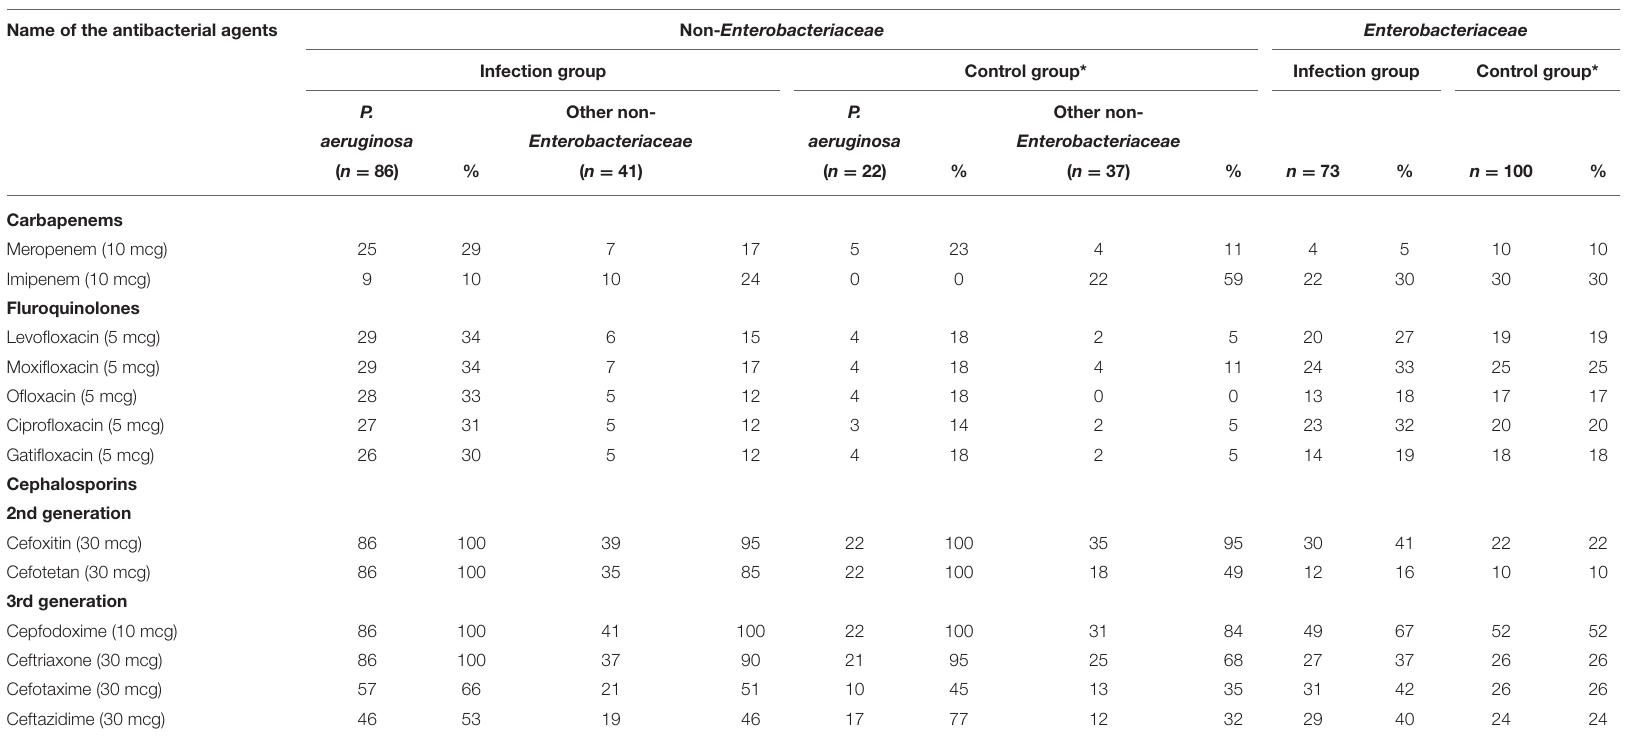
TABLE 3 | In-vitro antibiotic susceptibility profile of Non- Enterobacteriaceae vs. Enterobacteriaceae from infection vs. control